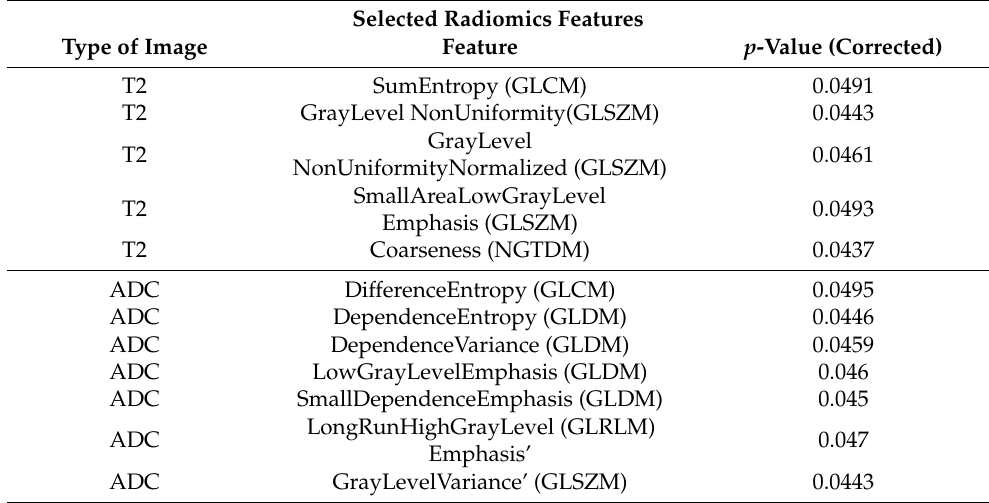
Figure 4. Statistically significant features which can individually separate between a low and a high/intermediate ESGO/ESTRO/ESP 2020 tumor classification. We report the number of statistically significant features after correction for multiple comparison divided by class types and modality. Blu refers to features obtained from T2w images; orange refers to features extracted from ADC maps. The features belong to the following class types: Gray Level Cooccurence Matrix (glcm), Gray Level Dependence Matrix (gldm), Gray Level Run Length Matrix (glrlm), Gray Level Size Zone Matrix (glszm), Neighbouring Gray Tone Difference Matrix (ngtdm). Table 5. A total of 12 features selected by multiple comparison false discovery rates fol- lowing the Benjamini–Hochberg procedure that were statistically significant with a corrected p -value p(FDR) <